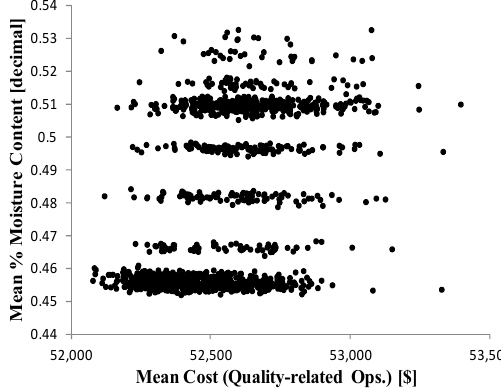
Figure 7. Average ash content vs. cost (schedule (*)).